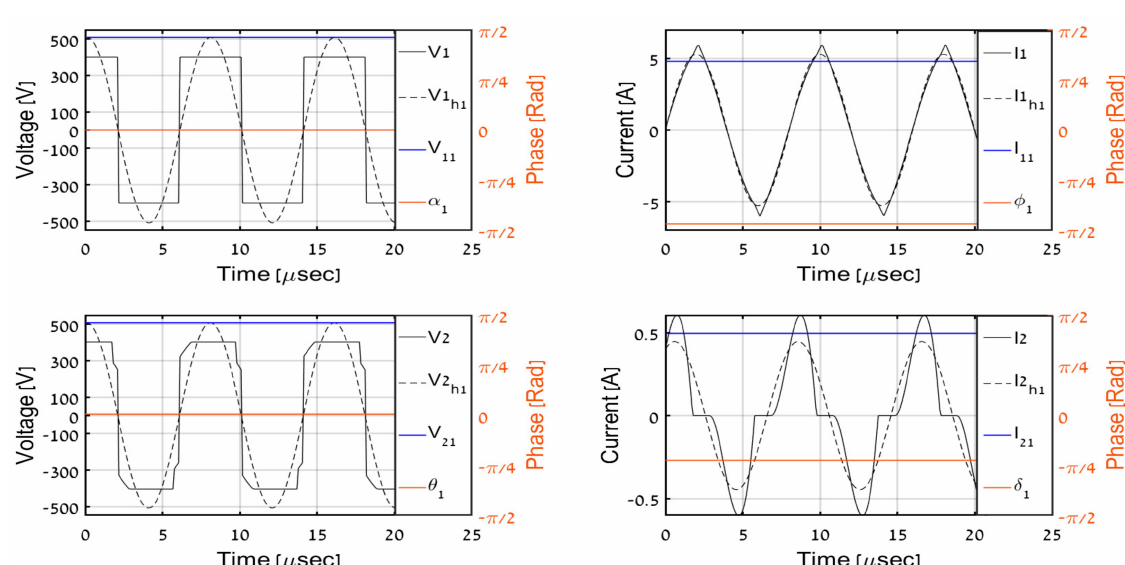
Figure 12. Simulation results, P O = 100